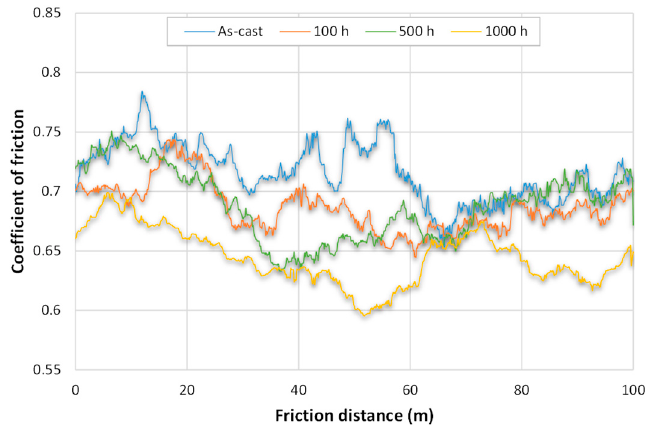
Figure 8. Coefficient of friction throughout the wear test on as-cast AlCoCrFeNi 2.1 and after aging at 800 °C at three different durations.